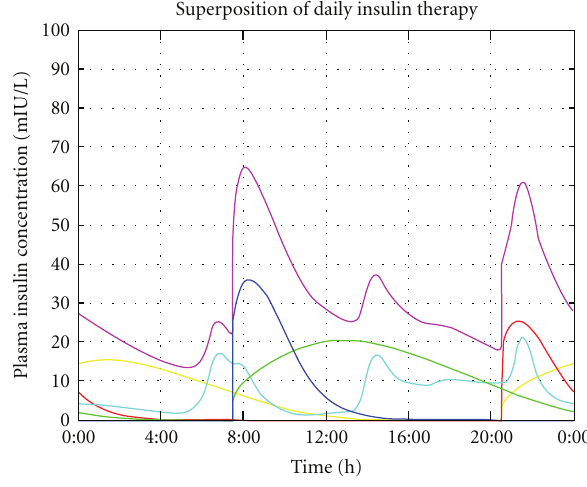
Figure 8: Prototype simulation using the superposition principle to calculate a plasma insulin profile based on exogenous insulin injections and estimated basal endogenous insulin secretion in a type 2 diabetic patient who takes 6 units of short-acting (regular) insulin and 12 units of intermediate-acting (NPH type) insulin in the morning with a further 4 units of short-acting (regular) insulin and 8 units of intermediate-acting (NPH type) insulin in the evening. The estimated basal endogenous insulin secretion is shown by the light blue (cyan) line—and the overall plasma insulin profile is